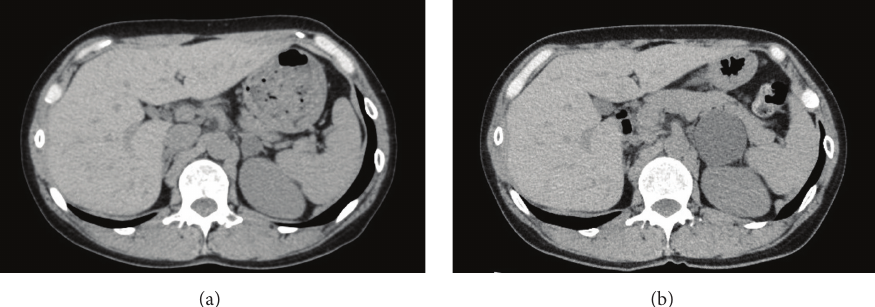
Figure 1: Unenhanced computed tomography of the abdomen showing a unilocular, noncalcified, hypoattenuating left adrenal lesion. The lesion increased in size from (a) 10mm to (b) 50 mm at two-year follow-up.